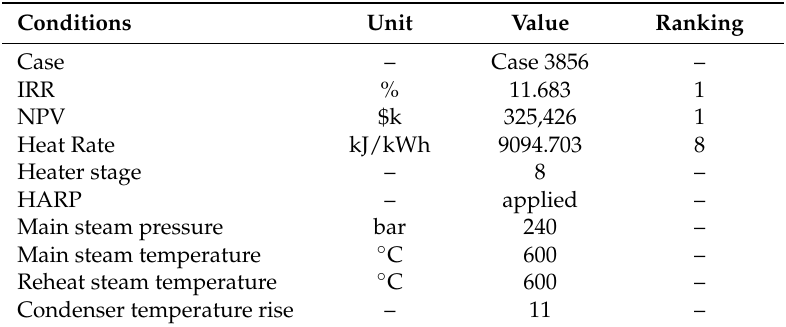
Table 7. Conditions of the case with the best